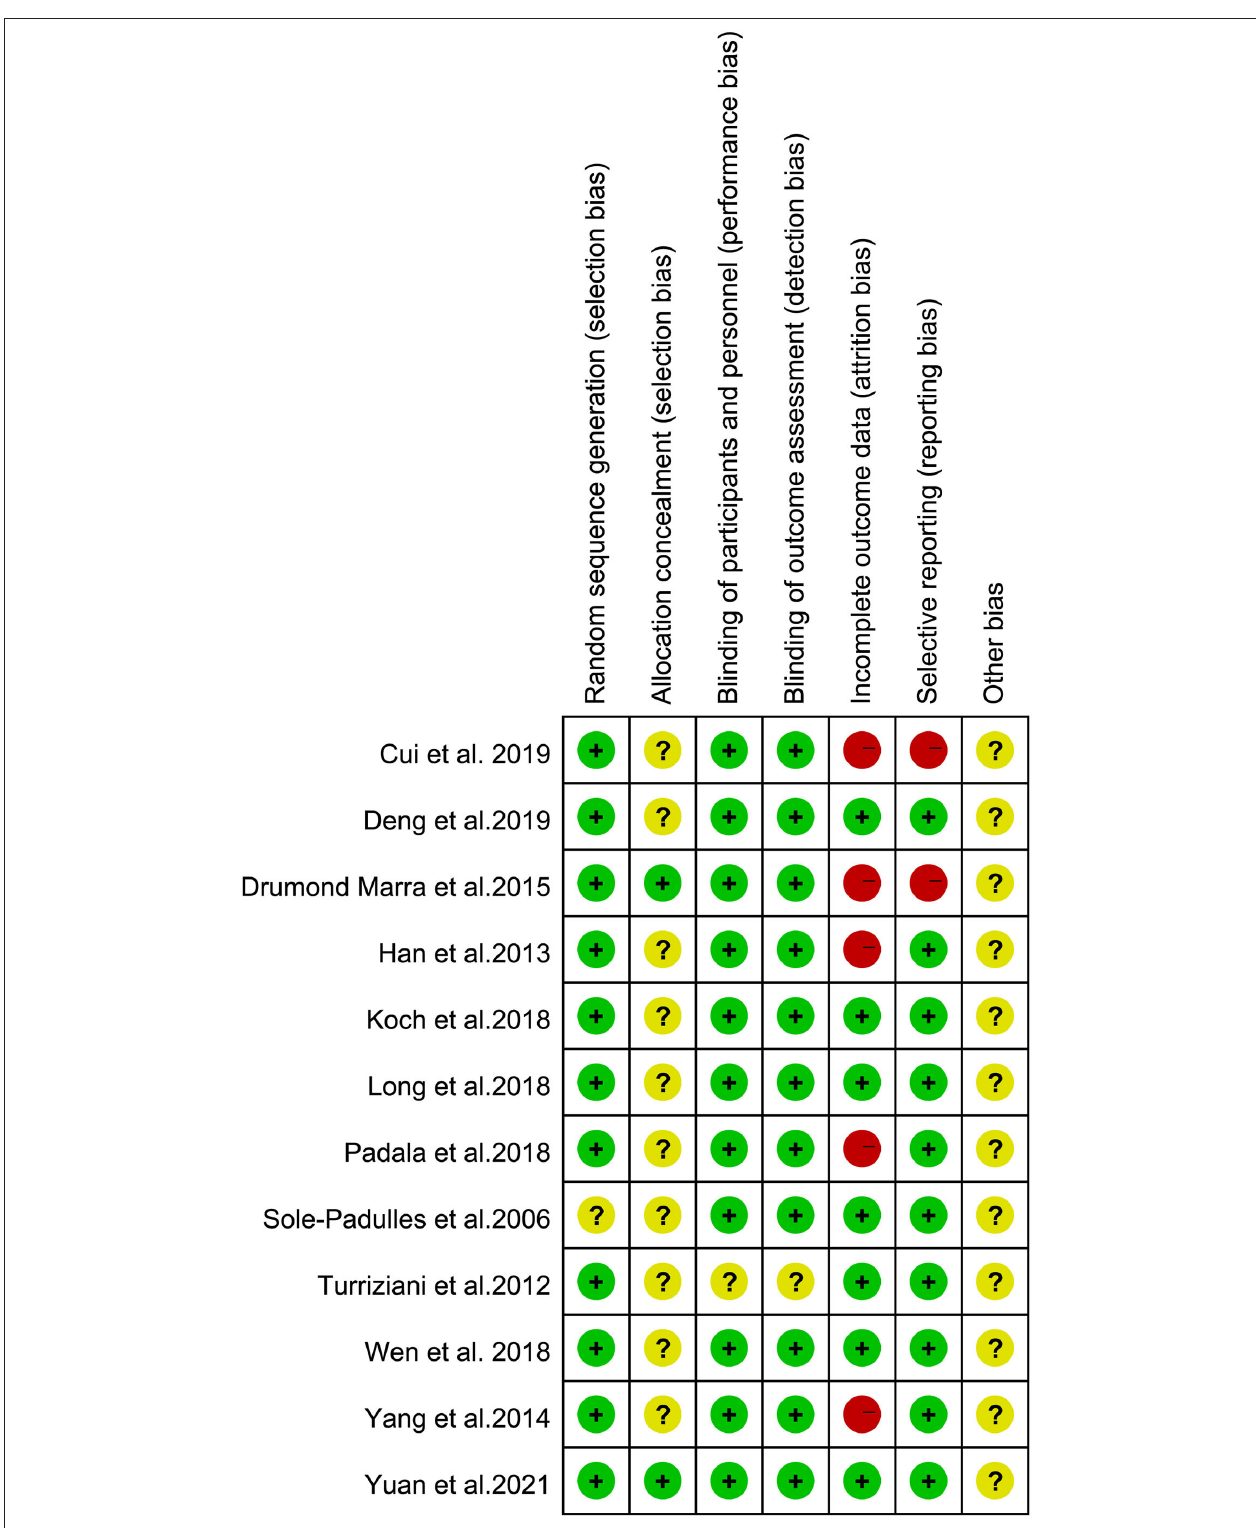
Frontiers in Human Neuroscience |